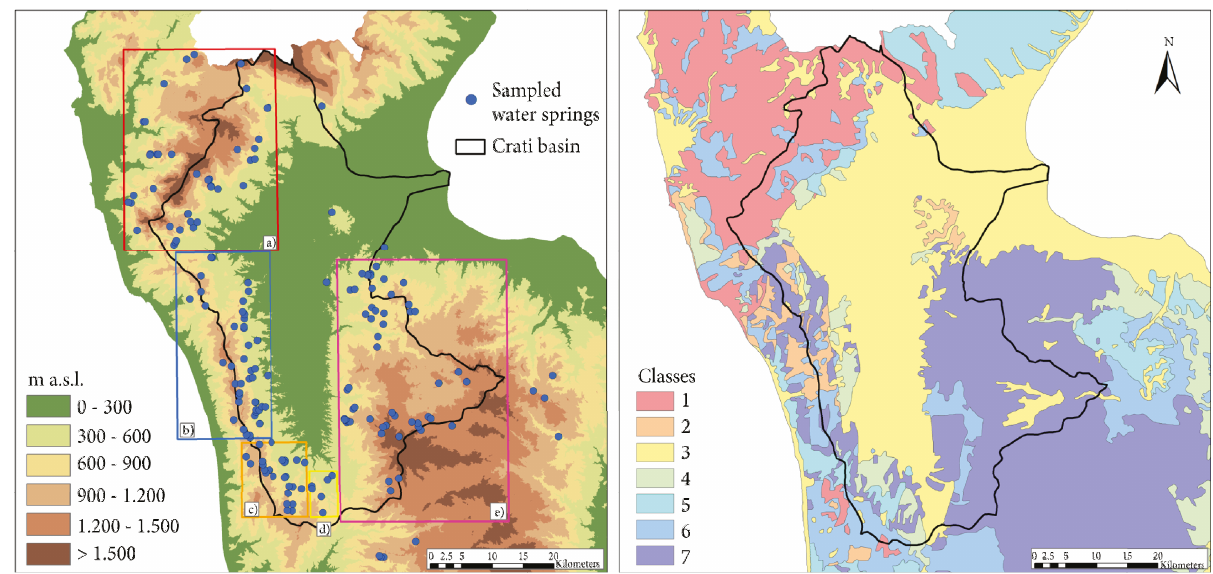
Figure 1: (a) Crati river basin with spring location and subzones delimited in this study: (A) Pollino Massif, (B) Coastal Chain, (C) Mt. Cocuzzo, (D) Serre Area, and (E) Sila Massif. (b) Lithological map of the basin. Lithological units are grouped into seven classes: (1) limestones and dolostones, (2) metamorphic rocks with ophiolites, (3) sand, clay and gravel, (4) clayely and marly terranes, (5) fl ysch, (6) sandstones, conglomerates and limestone banks, and (7) intrusive metamorphic